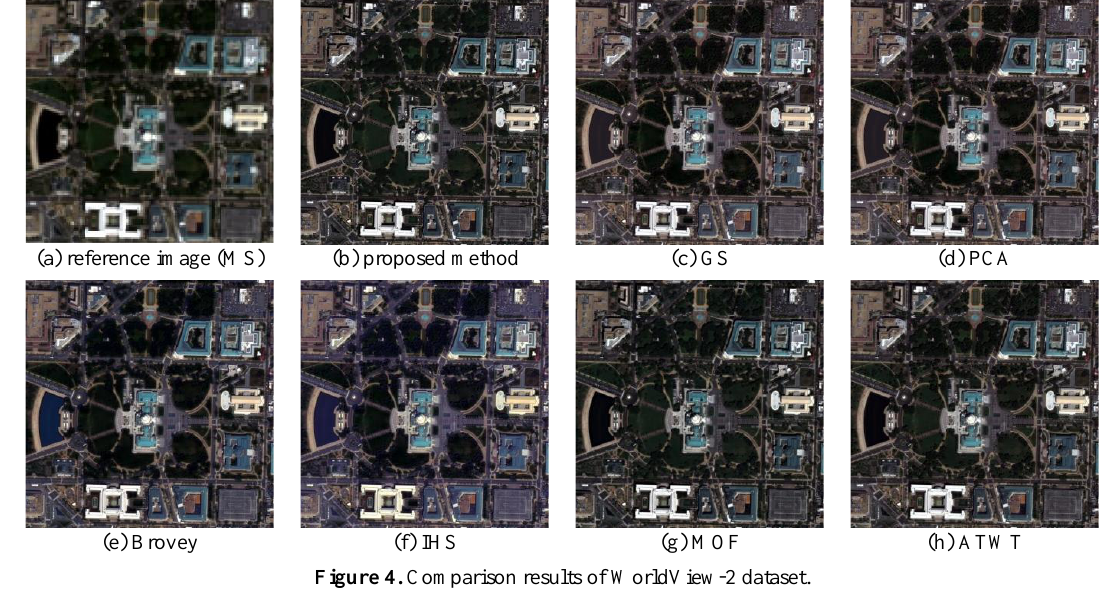
Figure 4. Comparison results of WorldView-2 dataset.